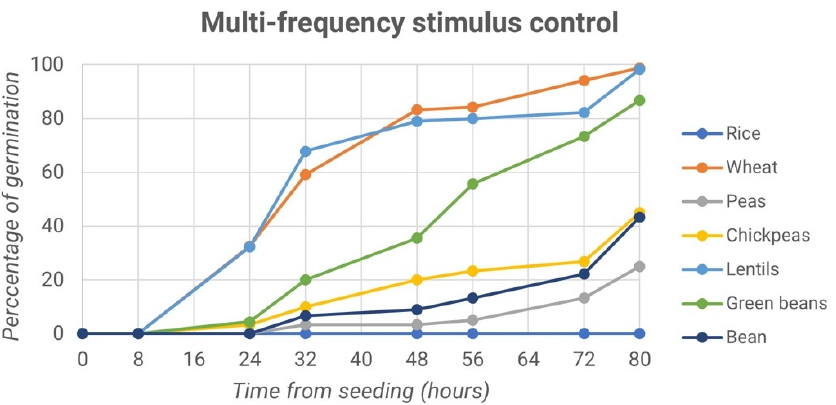
Figure 7. Percentage of germination vs. time from seeding: first experiment: multi-frequency stimulus control.